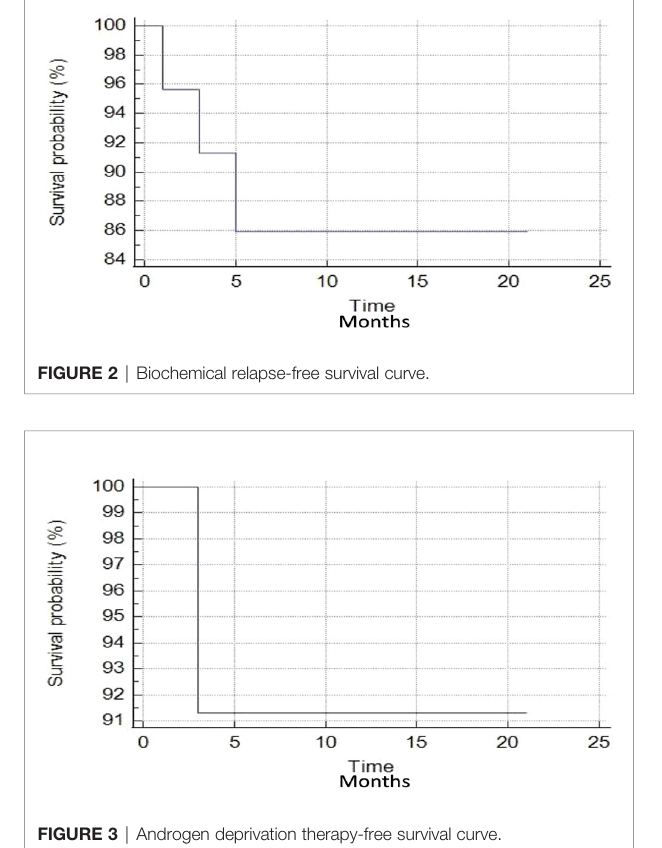
FIGURE 3 | Androgen deprivation therapy-free survival